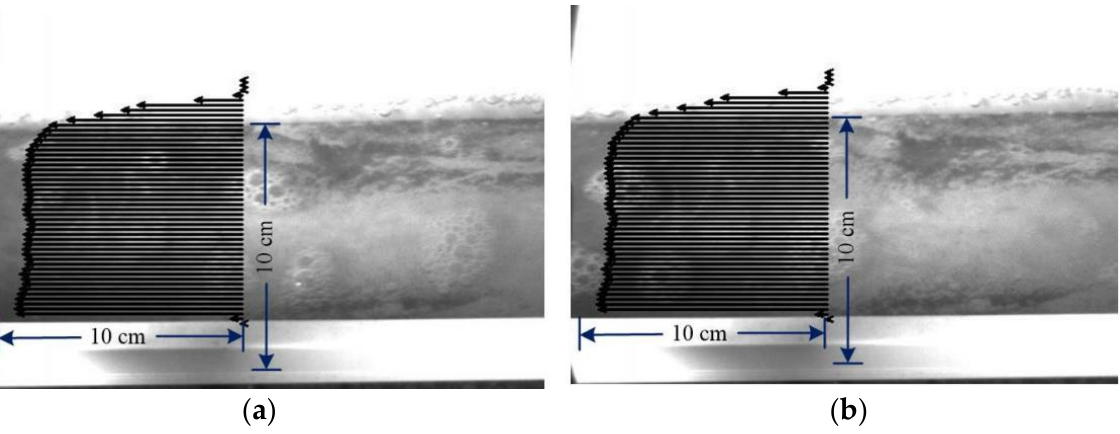
Figure 9. Visualization of optical flow field with different background image, showing ( a ) 18th frame and ( b ) 28th frame.